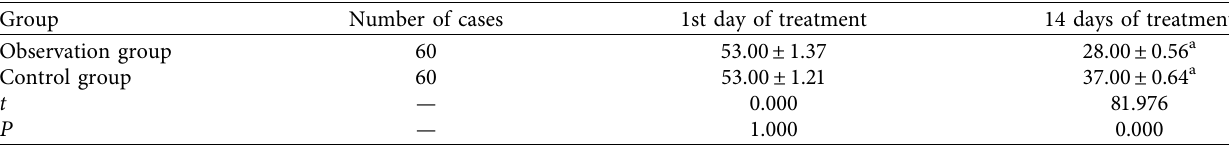
Table 4: Comparison of sleep medication dosage changes before and after treatment in the two groups of patients ( x − ± s , mg). Group Observation group